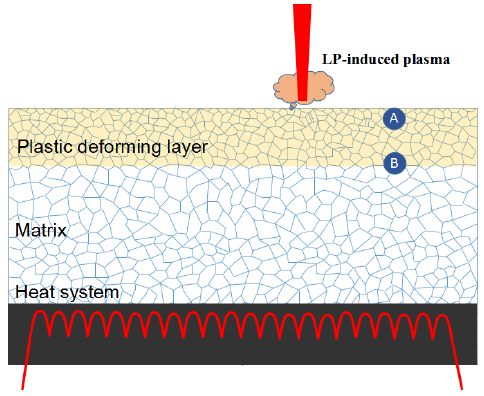
Figure 2. Set-up of warm laser peening.